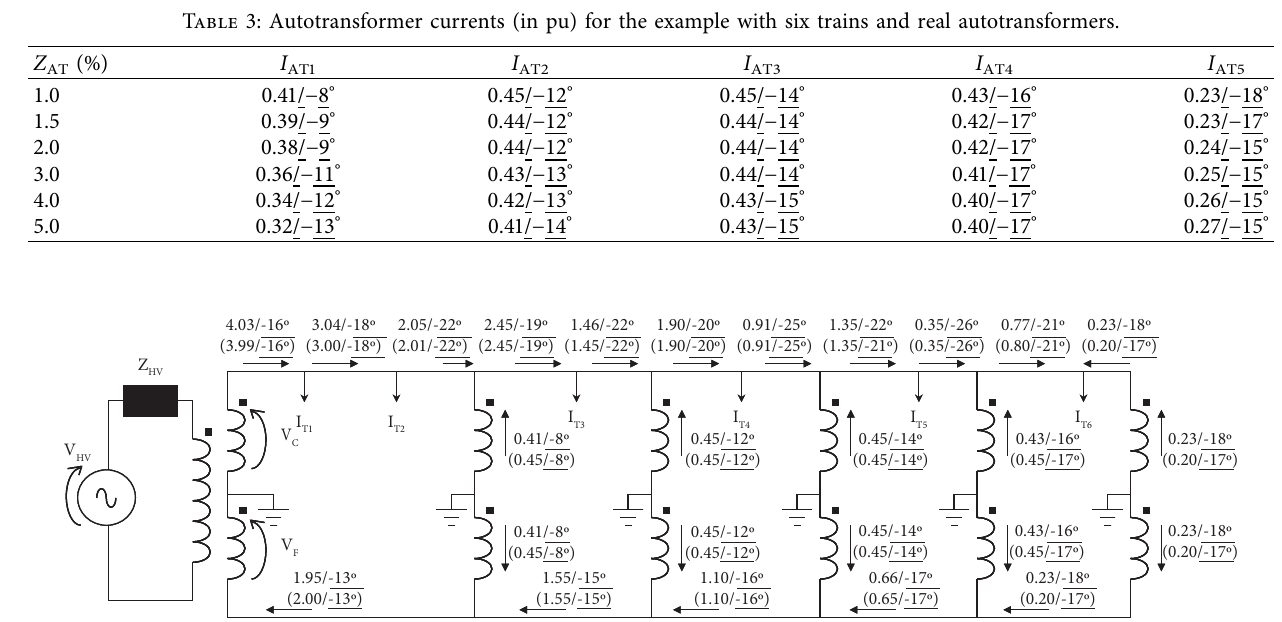
Figure 10: Distribution of currents for the example with six trains (results with Z with Z AT � 0% are shown between parenthesis). Table 4: Autotransformer currents (in pu) for the example with six trains and the nonlinear method. First example.